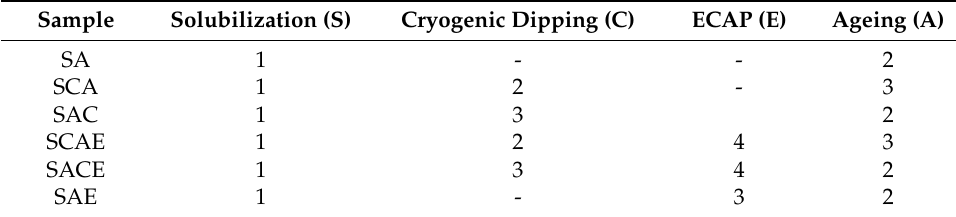
Table 1. Sequence of the treatments applied to the AA6012 alloy samples. Sample Solubilization (S) Cryogenic Dipping (C) ECAP (E) Ageing (A) SA SAC SCAE